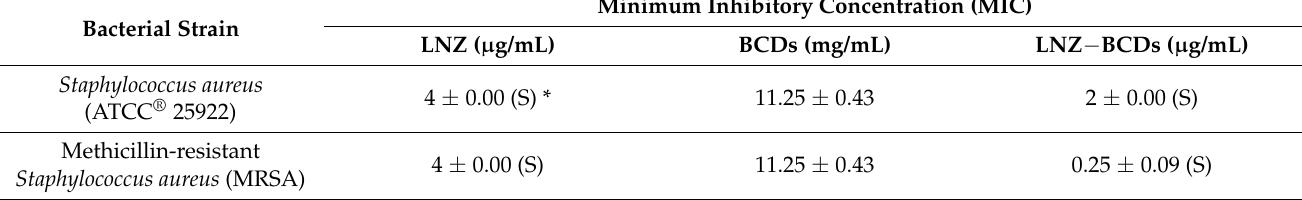
Table 3. Results of MIC of LNZ, BCDs nano-biocarrier, and LNZ − BCDs nano-bioconjugate against different bacterial